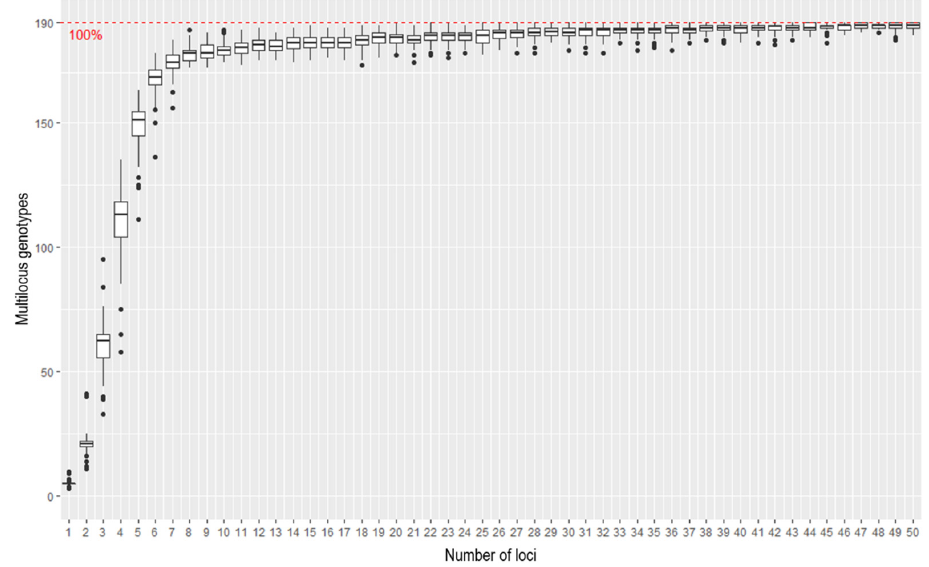
Figure 2. A genotype accumulation curve, used for determining the minimum number of loci necessary to discriminate between individuals in a population.